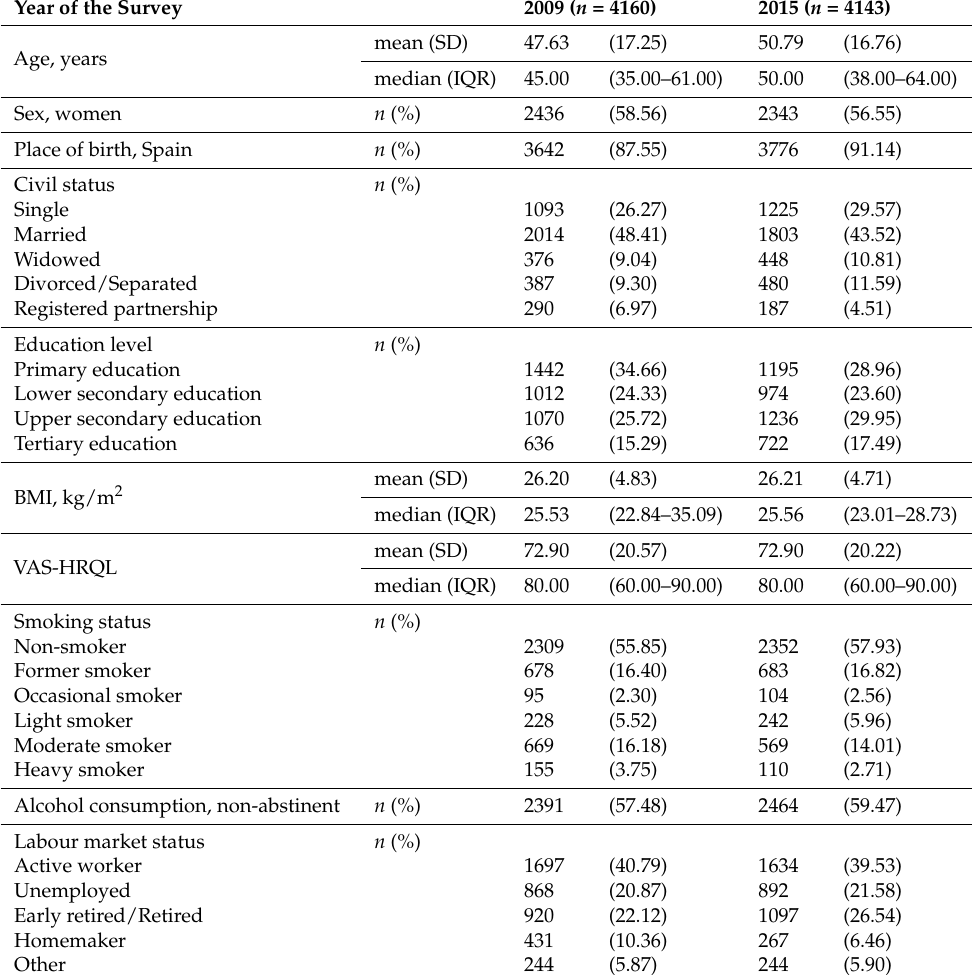
Table 1. Characteristics of participants according to year of the survey.